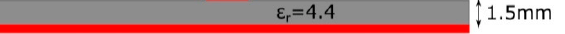
Figure 3. A cross-section of the patch antenna arrays.